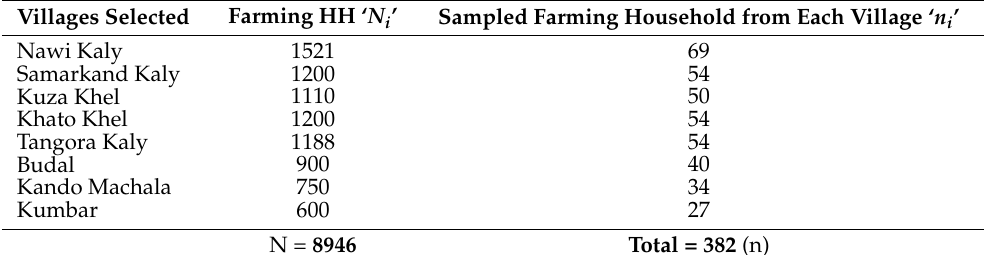
Table 1. Selection of villages, farming households, and proportional allocation of farmers in each village. Villages Selected